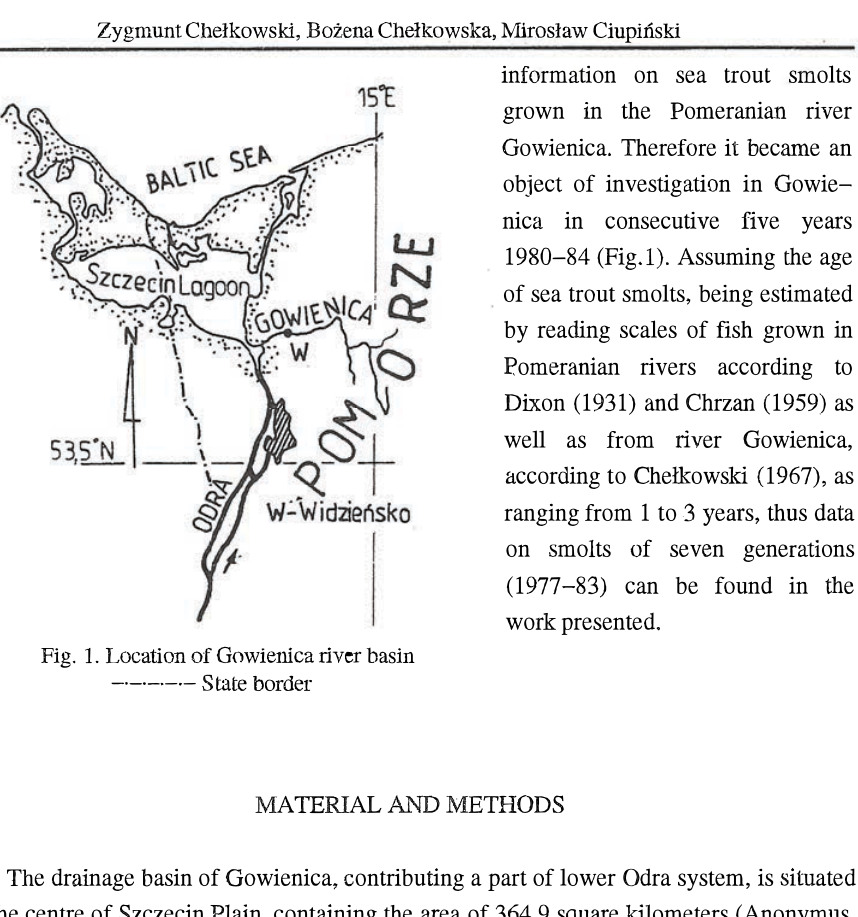
(Fig.l). Assuming the age